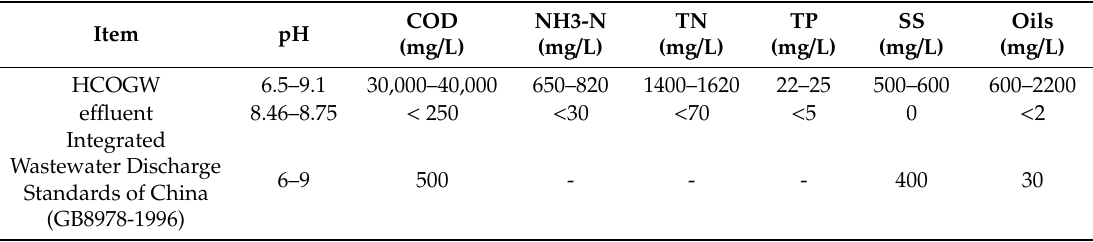
Table 2. Treatment performance of a full-scale sequencing batch reactor and a ceramic membrane bioreactor (SBR + CMBR) process during a stable running